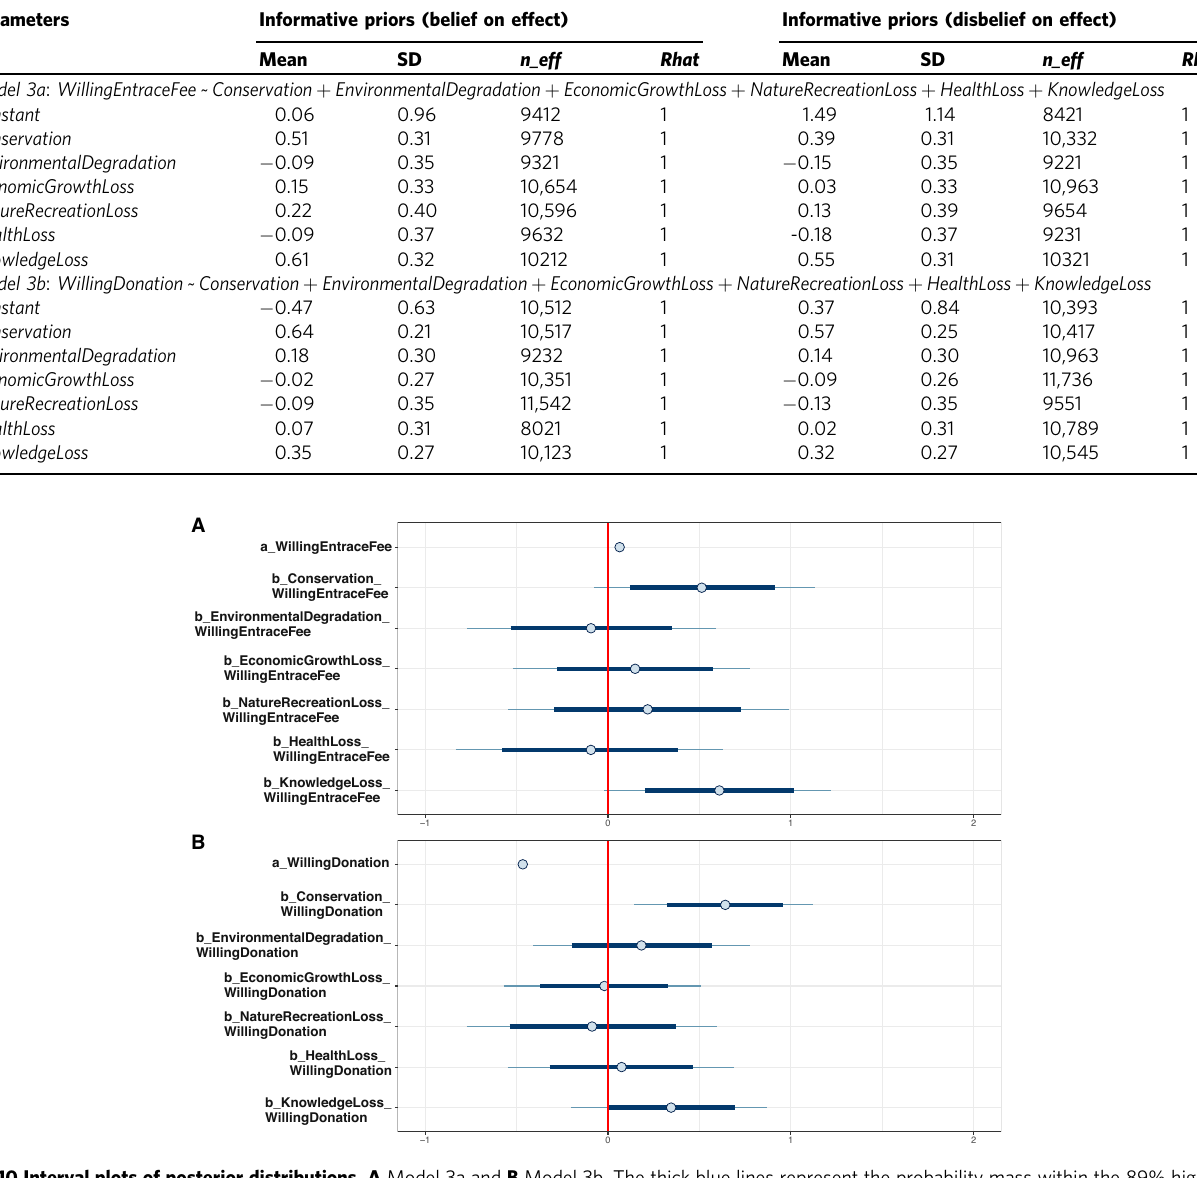
Fig. 10 Interval plots of posterior distributions. A Model 3a and B Model 3b. The thick blue lines represent the probability mass within the 89% highest posterior density intervals, while the thin blue lines represent the probability mass located outside the highest credible